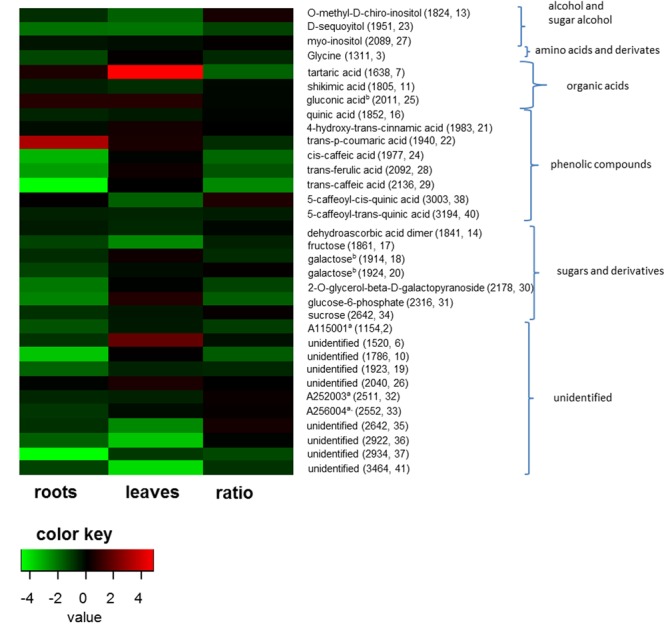
Fold changes of metabolite levels in roots, leaves and ratios from plants inoculated with protists (n = 10) compared to not inoculated plants (n = 10). Fold changes were logarithmized for better visualization. Only fold changes lower than 0.66 and higher 1.5 are shown. Color key represents fold changes of the metabolites from strong decrease (green) to high increase (red) in the presence of protists. Ratio shows the fold changes of leaf/root ratios. Parentheses show the retention time and internal numbering according to Table 2 of the metabolites.